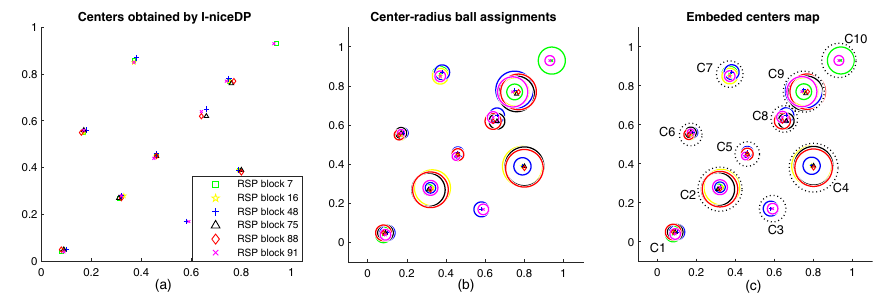
Fig. 2 Illustration of the results of three steps of the RSPCE algorithm from six random samples of dataset DS1. a Individual centers were obtained from the 6 randomly chosen samples by I-niceDP, b Cluster balls of the centers, c Ensemble centers of the 6 samples by the RSPCE